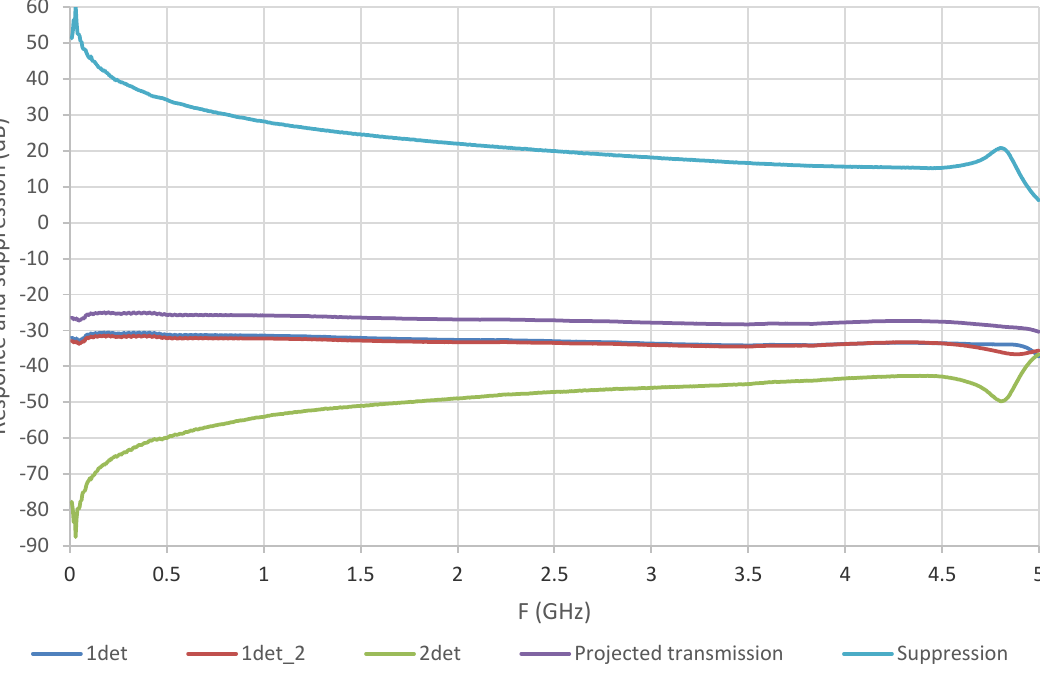
Figure 5. Common mode noise suppression by balanced detection. “1det”—system transmission coefficient curve with a single detector connected (first one); “1det_2”—system transmission coefficient curve with a single detector connected (the second one); “2det” curve−difference between two channels; “Projected transmission”—system transmission coefficient curve with balance detection; “Suppression”—system common-mode rejection with balance detection.